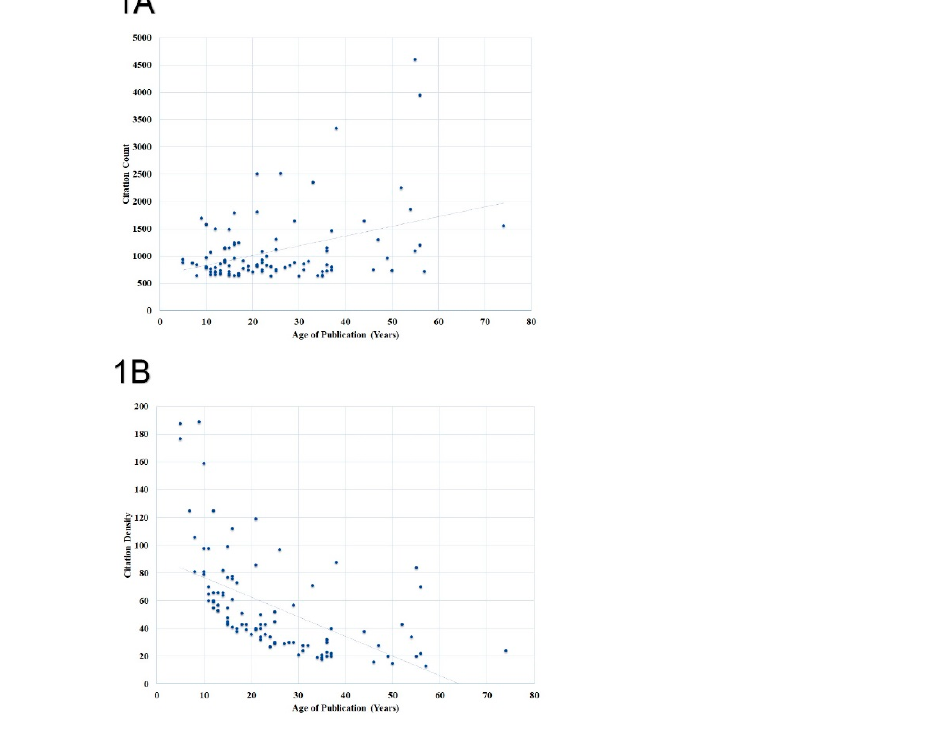
Figure 1. Association of ( A ) citation count and ( B ) citation density with the age of publication. The dot represents individual publication and line represents trendline.